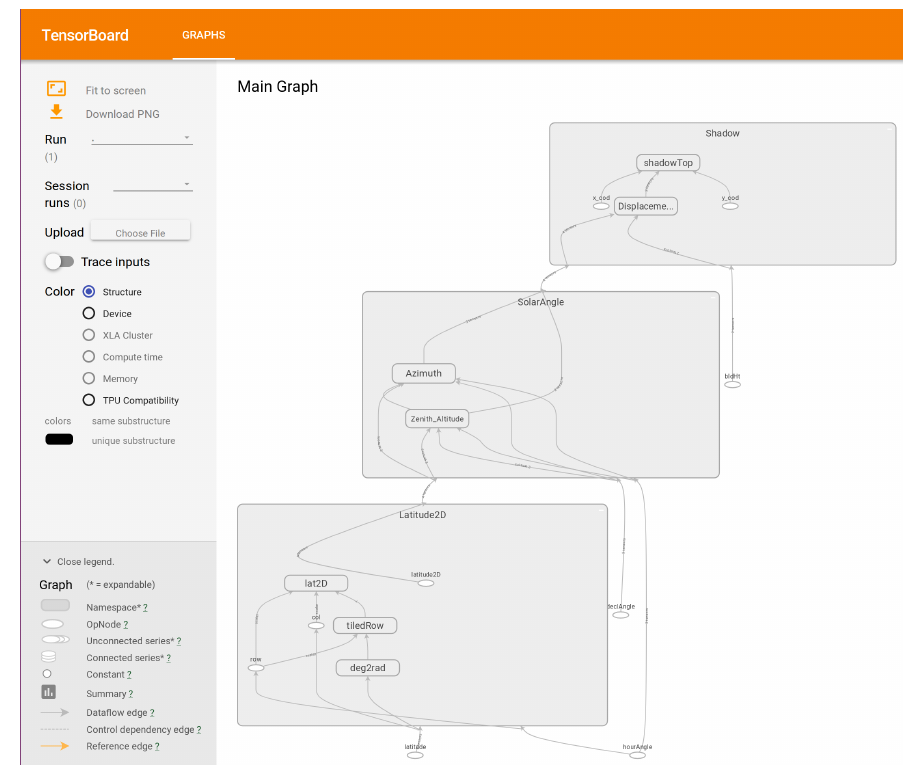
Figure 9. Dataflow graph generated by TensorBoard.